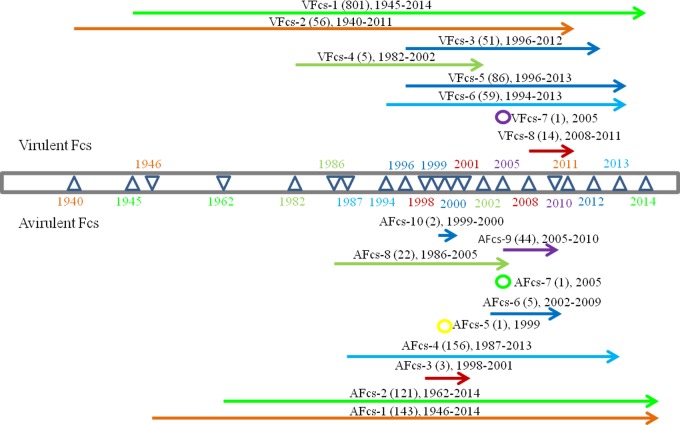
Timeline of Fcs variants in NDV natural isolates.F cleavage sites are illustrated in Tables 1 and 2. Each triangle represents a year of time. The upper panel indicates information for virulent Fcs, and the lower panel indicates avirulent Fcs.